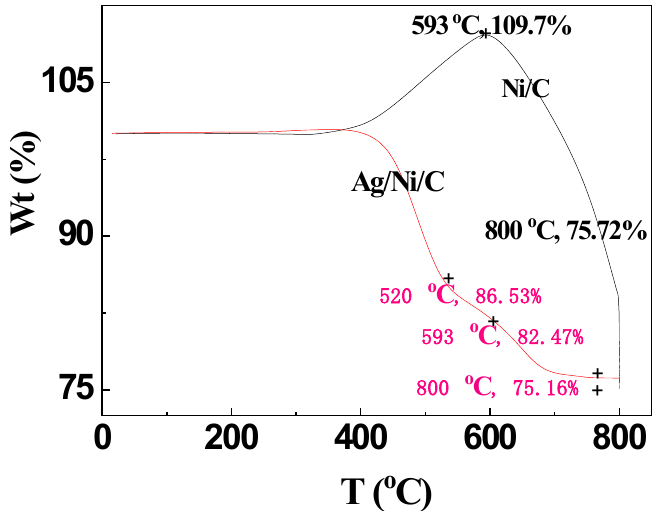
Figure 6. TGA curves of the samples: Ni/C and Ag/Ni/C powders (Balance Gas: Nitrogen 40.0 mL/min; Sample Gas: Air 60.0 mL/min; 1: Ramp 10.0 °C/min to 800.0 °C; 2: Isothermal curing for 120.0 min).